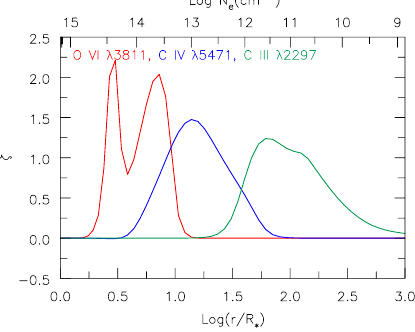
Figure 13. Illustration of where O VI λ 3811, C IV λ 5471, and C III λ 2297 originate in the wind. (cid:82) ζ d ln r is proportional to the emission. High excitation lines originate in the inner denser wind, while lower excitation lines originate in the outer